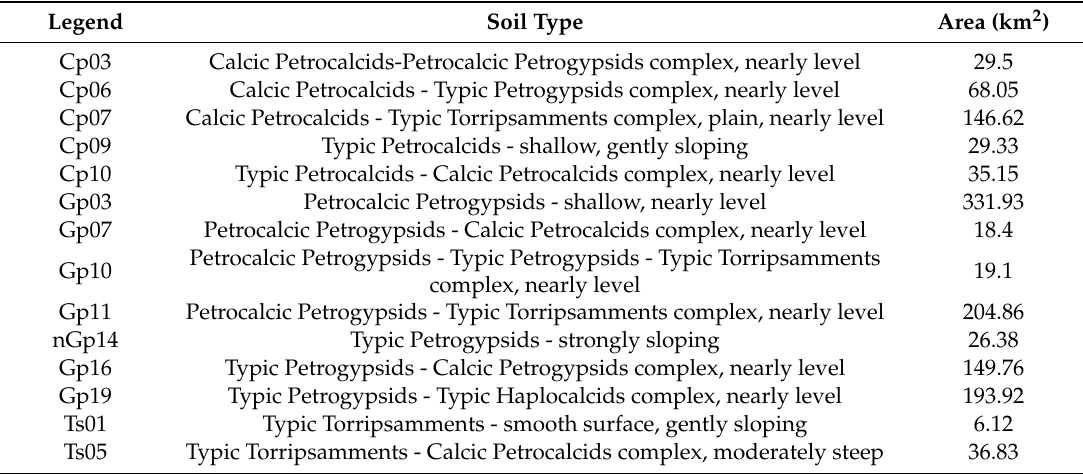
Table 1. Soil type classification over the test